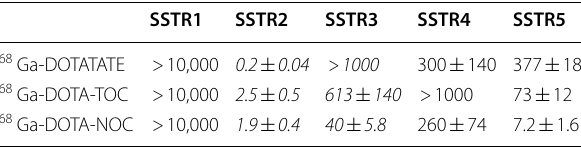
receptors. Depicted are in vitro affinity profiles (50% inhibitory concentration (IC50) in nM ±